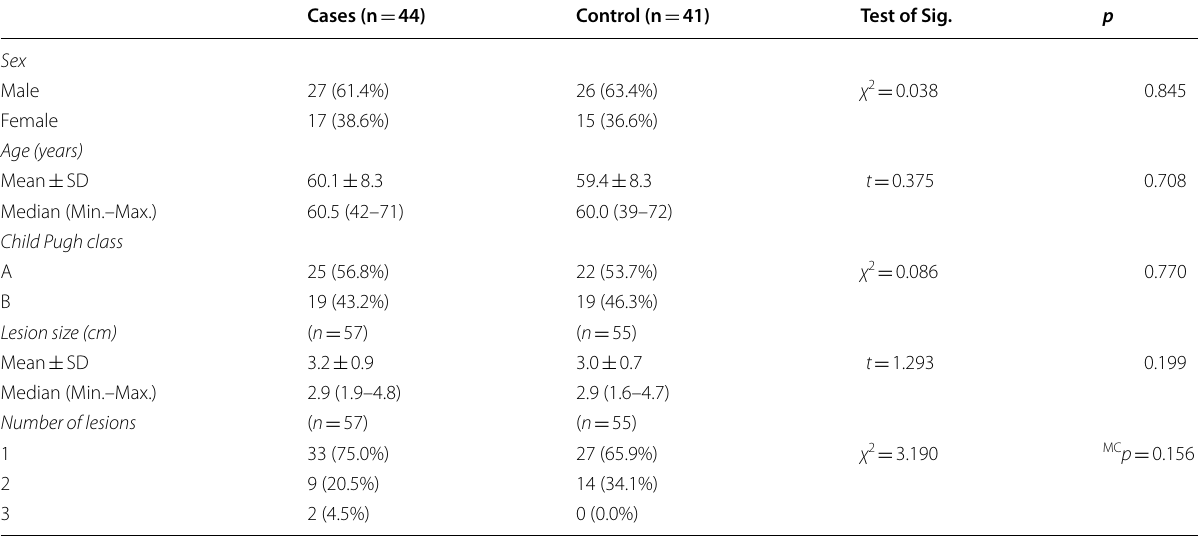
Table 1 Comparison between the two studied groups according to different